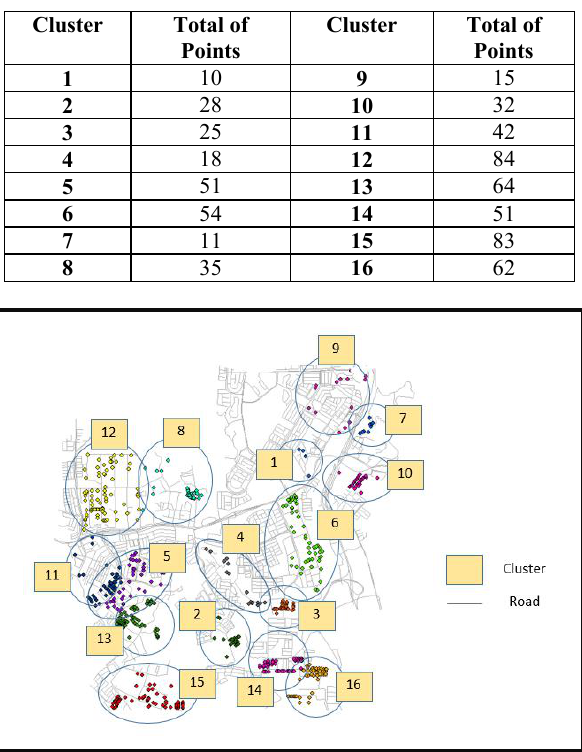
Figure 7 16 cluster of points generate from grouping